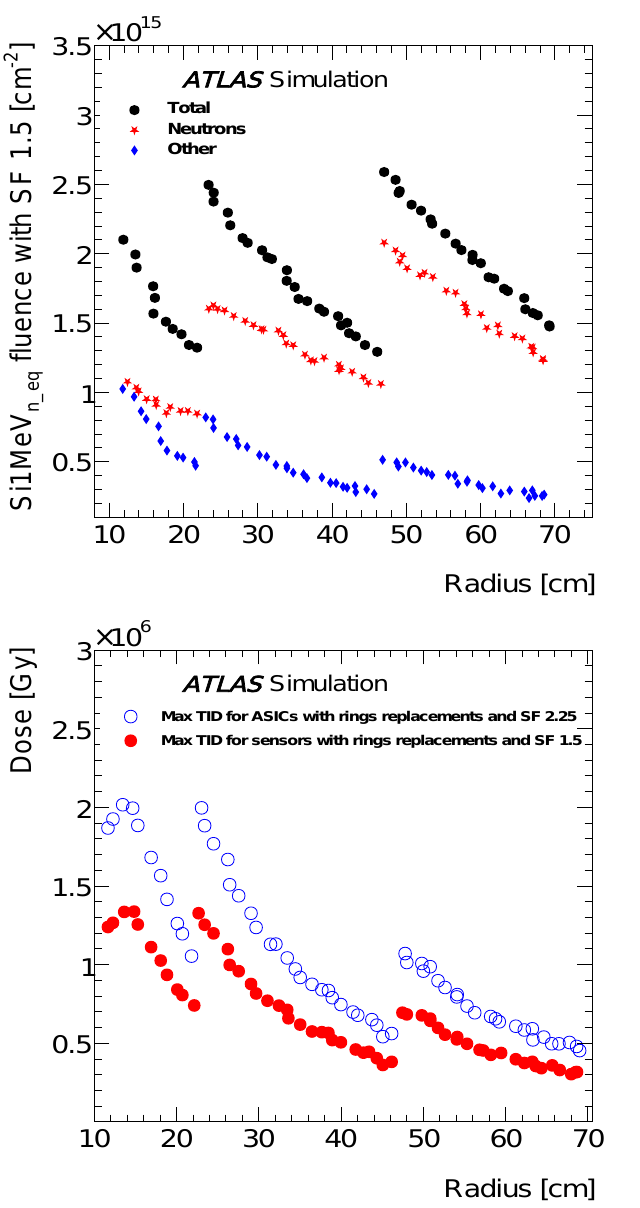
Fig. 3: Expected Si 1 MeV n eq radiation levels in HGTD, using Fluka simulations, as a function of the radius considering a replacement of the inner ring every 1 000 fb − 1 and the middle ring replaced at 2 000 fb − 1 [3].